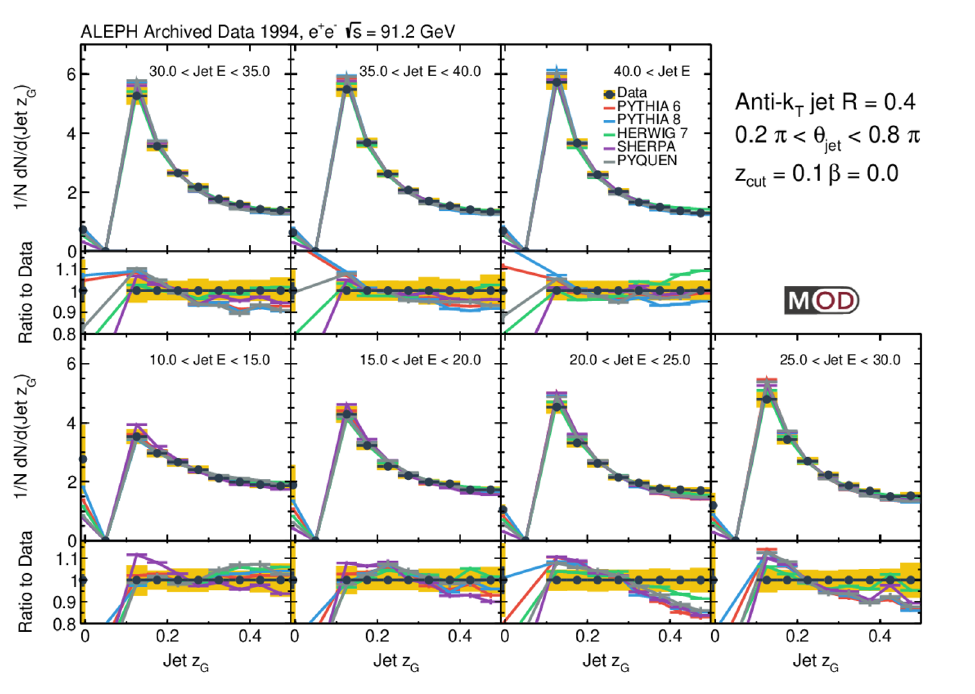
Figure 15 . Measured z G spectra in bins of jet E . The spectrum is self-normalized for each E interval. The fraction of jets completely groomed away are included in the first bin of each panel. The data is also compared with predictions from Pythia 6 (red), Pythia 8 (blue), Herwig (green), and Sherpa (purple)